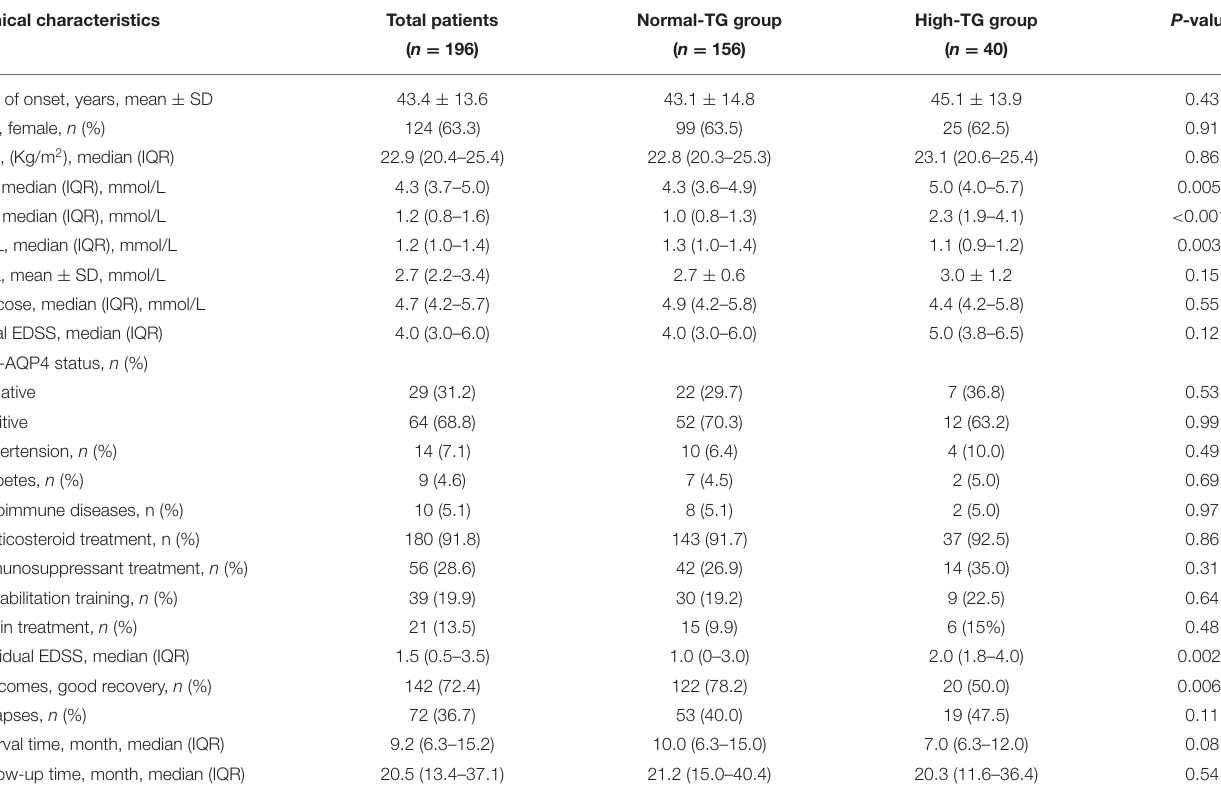
TABLE 1 | Characteristics of the patients with first attacked NMOSD according to TG